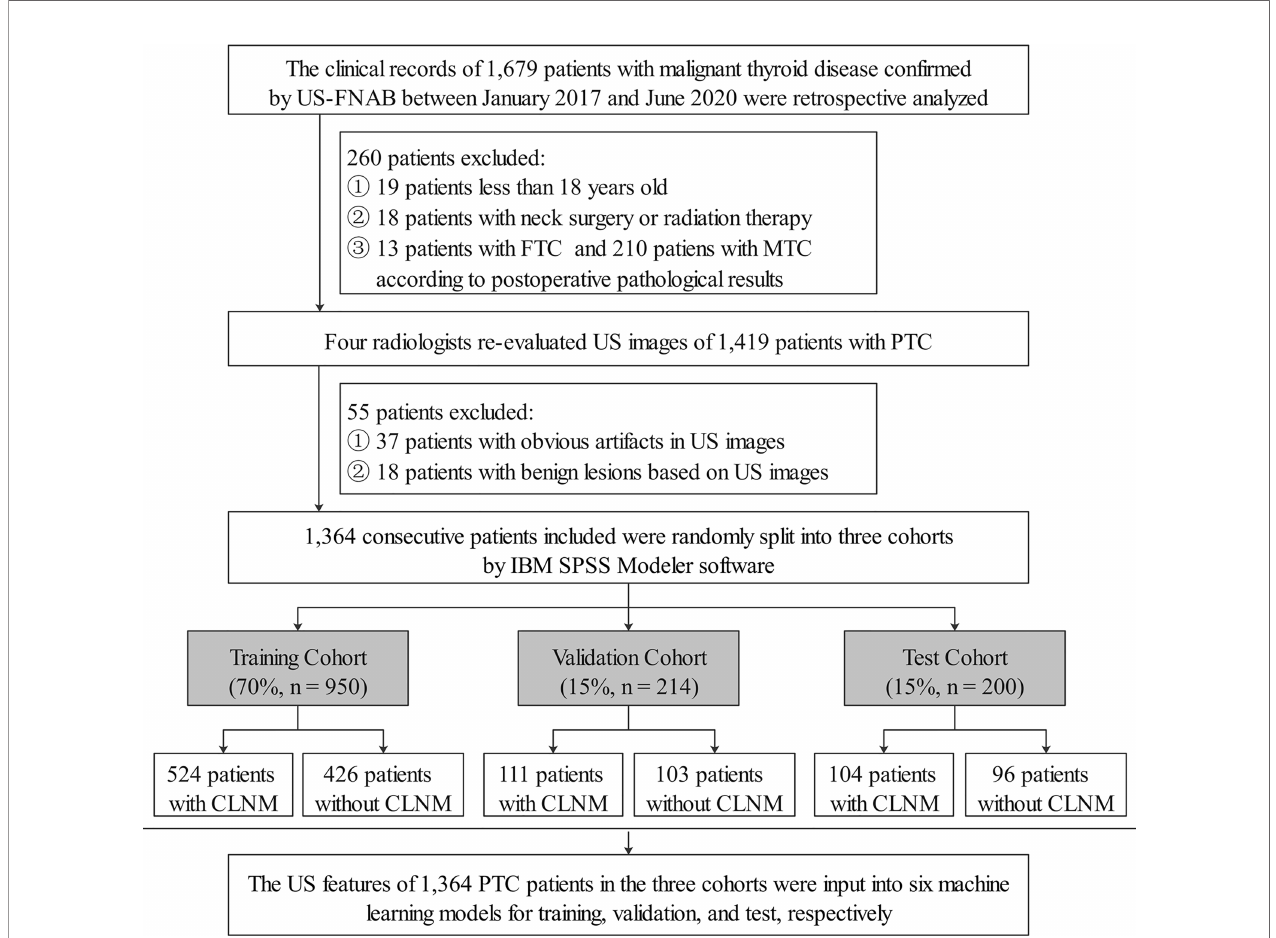
FIGURE 1 | Flowchart showed inclusion and exclusion criteria of PTC patients in the current study. US-FNAB, ultrasound-guided fi ne-needle aspiration biopsy; FTC, follicular thyroid carcinoma; MTC, medullary thyroid carcinoma; US, ultrasound; PTC, papillary thyroid carcinoma; CLNM, central cervical lymph node